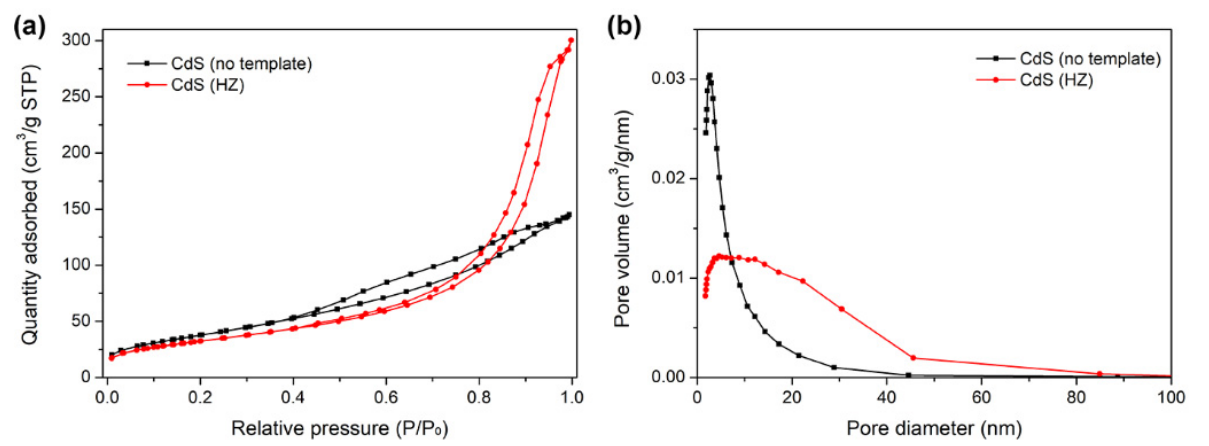
Figure 3. ( a ) N 2 adsorption/desorption isotherm and ( b ) pore size distribution of CdS(HZ) and CdS prepared without template.